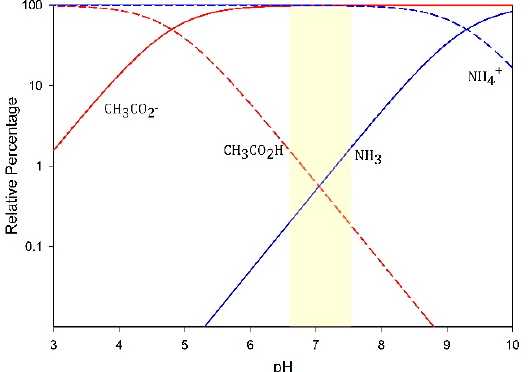
Figure 4. Bjerrum plot with the relative concentrations of acetic acid and its conjugate base, and of ammonia and its conjugate acid. The shaded area represents the mean pH of the digesters ± standard deviation of the mean.